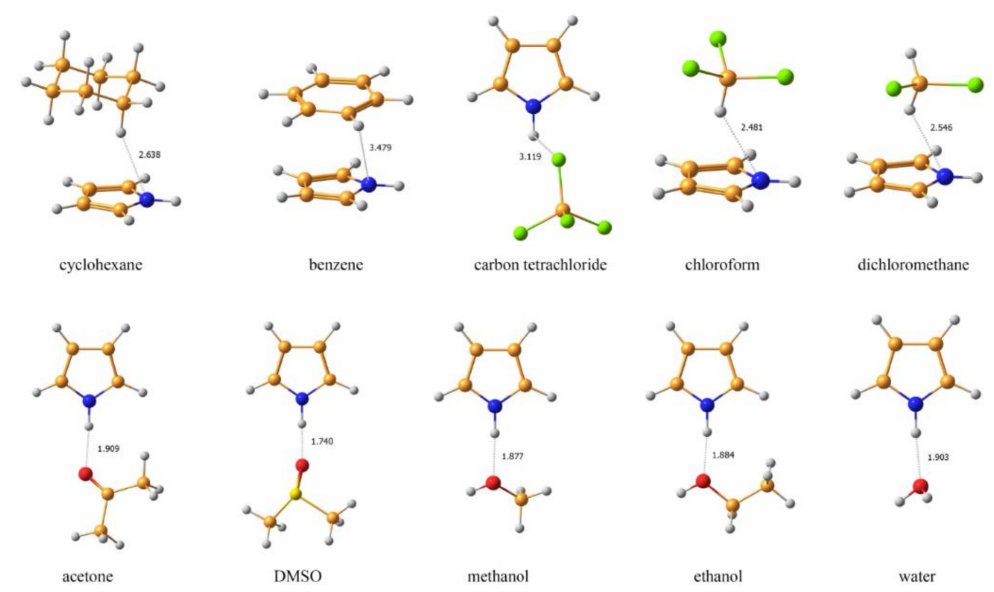
Figure 7. Equilibrium geometries of the SSM complexes of pyrrole with different solvents optimized at the MP2/6- 311++G(d,p) level with taking into account bulk solvent effect within the IEF-PCM scheme. The most representative interatomic distances are given in Å. Reproduced from Semenov et al. [96] with the permission of John Wiley and